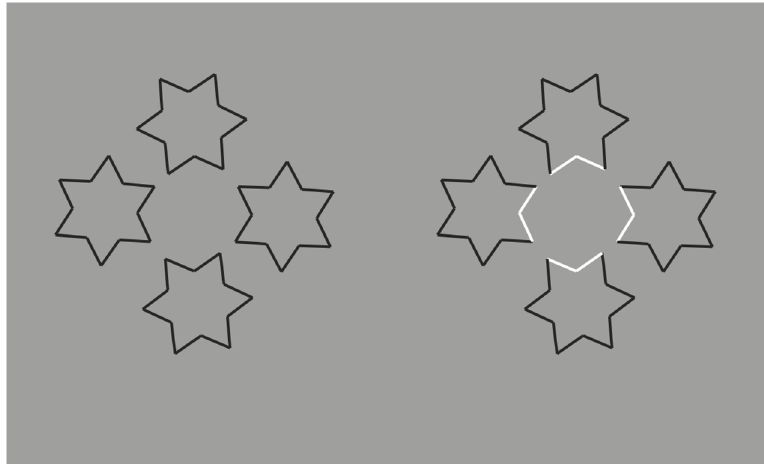
Figure 6. Similarity by contrast polarity pitted against closure and proximity principles.